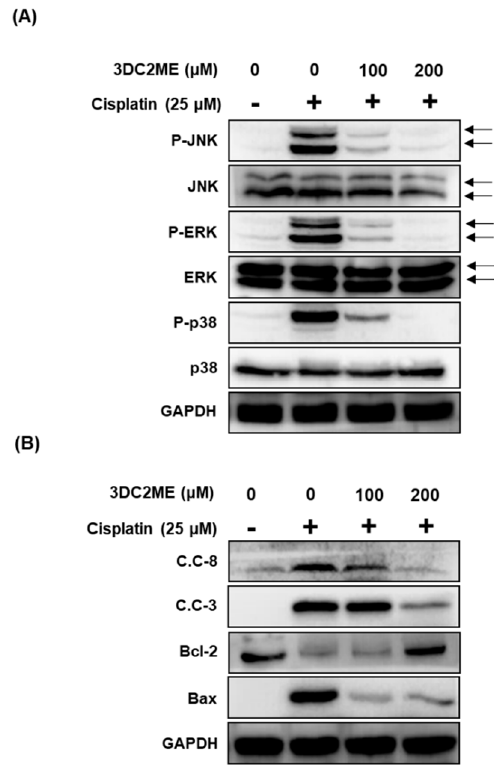
Figure 4. Effects of 3DC2ME on protein expression of proteins associated with ( A ) MAPK and ( B ) apoptosis pathways in LLC-PK1 cells exposed to 25 μ M cisplatin by western blot. Control cells were treated with the vehicle only (mean ± SD, * p < 0.05 compared to the control). 3-Dehydroxyceanothetric acid 2-methyl ester, 3DC2ME; phosphor-c-Jun N-terminal kinase, P-JNK; phosphor-extracellular